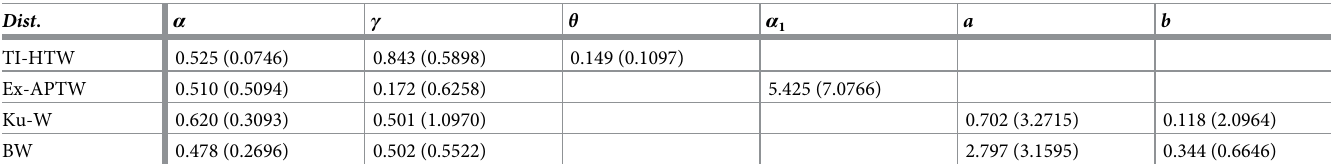
Table 9. Estimated values of the model parameters with standard error (in parenthesis) of the fitted models for data 2. Dist .